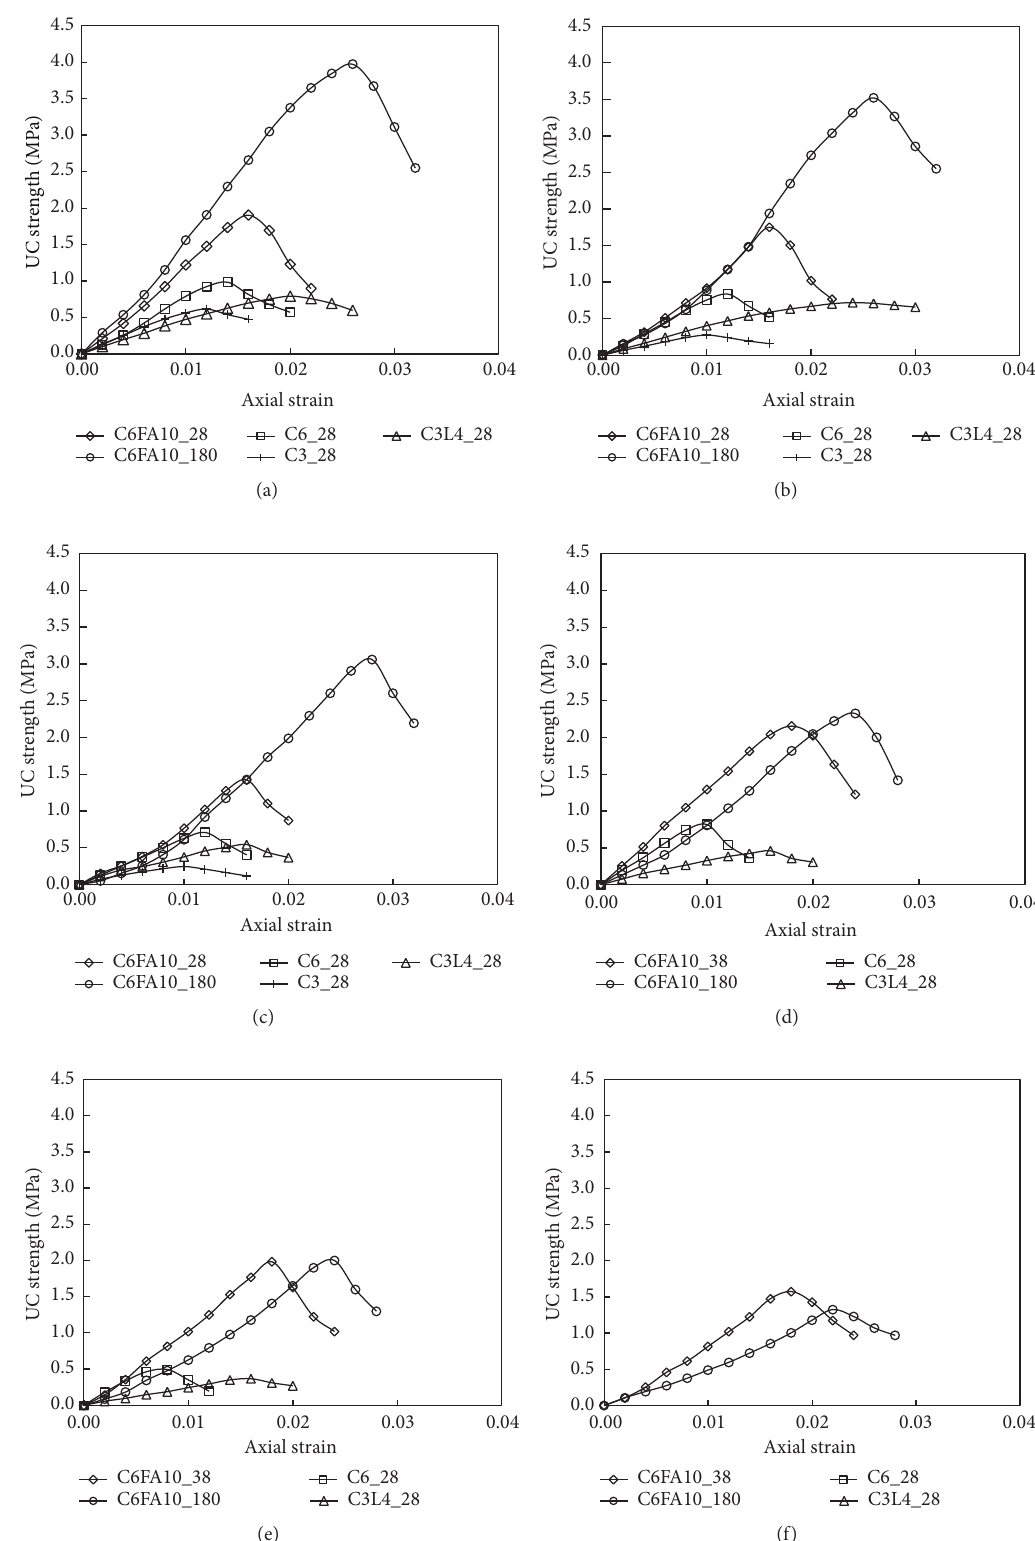
Figure 8: Stress-strain curves in UC strength tests drawn at the same scale for samples subjected to different freeze-thaw cycles: (a) no frost actions, (b) 1 cycle, (c) 3 cycles, (d) 5 cycles, (e) 7 cycles, and (f) 9